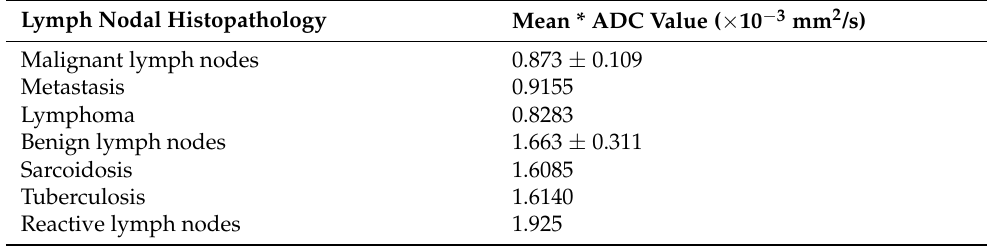
Table 2. ADC mean values of lymph nodes from different etiologies.